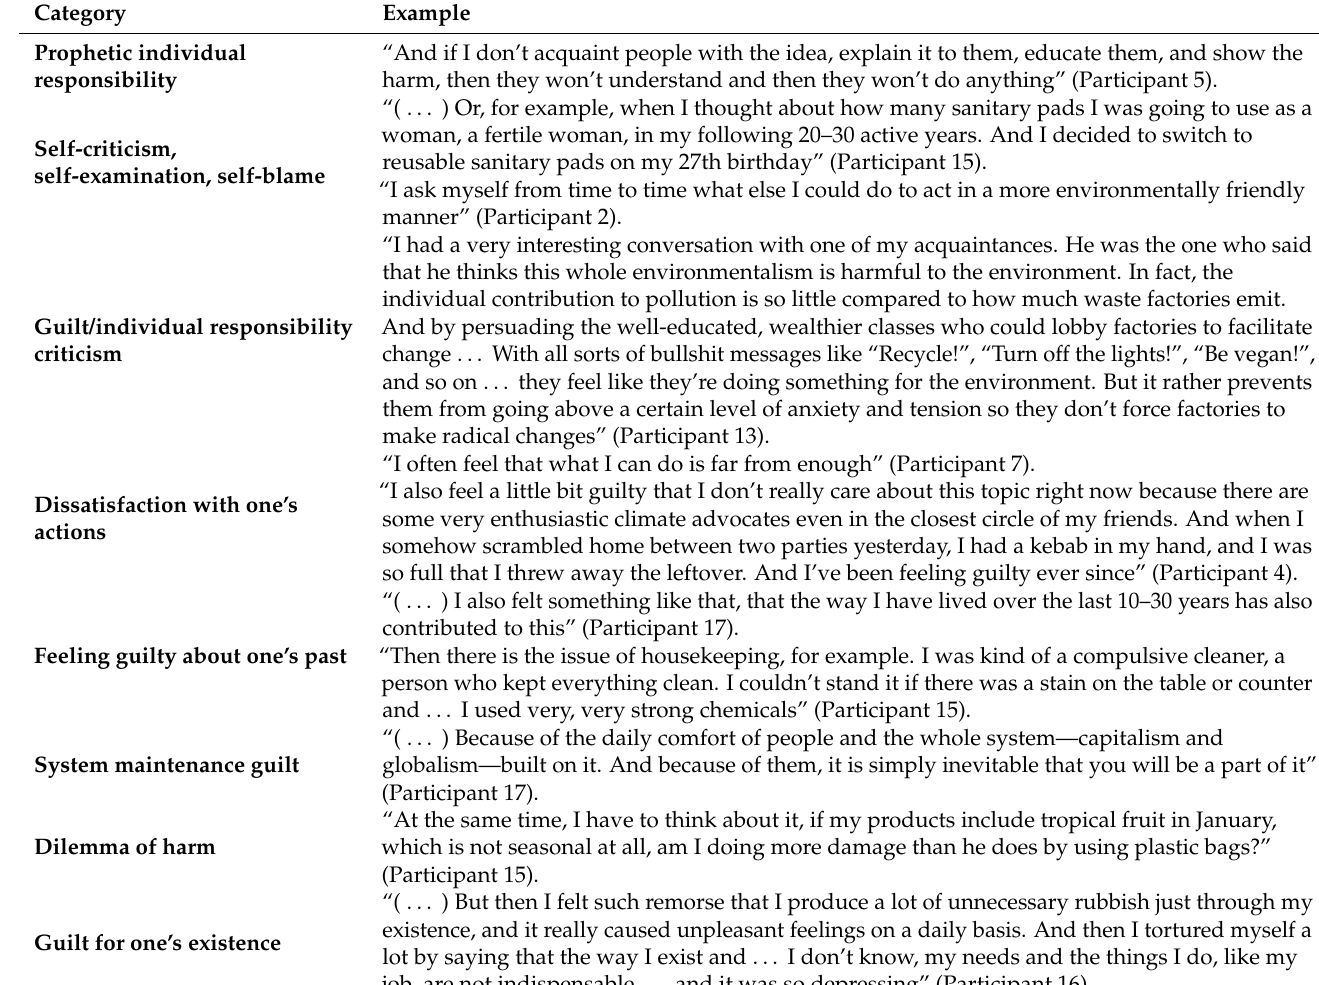
Table 3. Aspects of